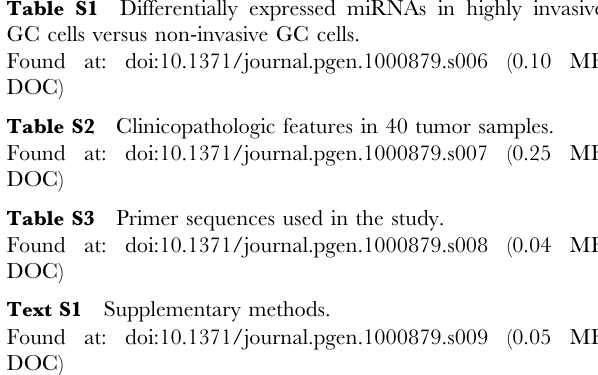
Table S1 Differentially expressed miRNAs in highly invasive